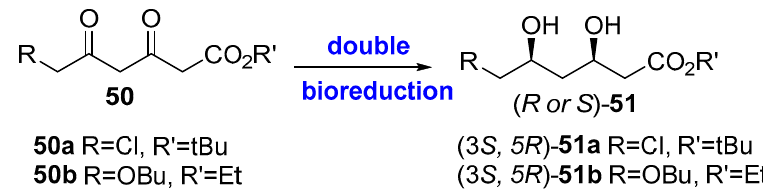
Figure 13. Bio-reductions of dioxoesters to produce chiral building blocks for statins.